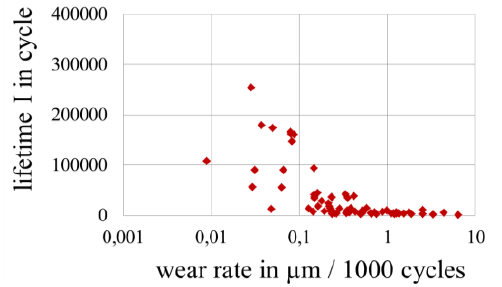
Figure 33. Correlation between rate of wear of gold platings and lifetime I of electrical contacts.